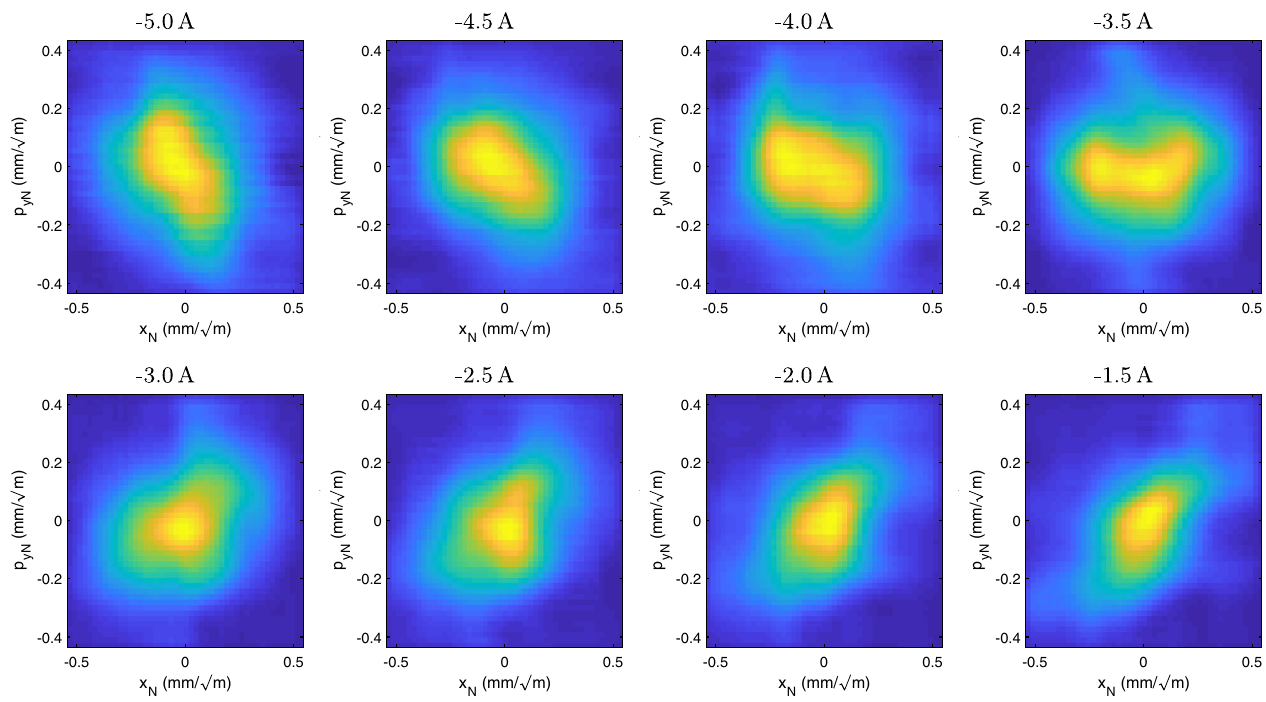
– p FIG. 11. Projection of the beam distribution in normalized phase space onto the x y N plane, reconstructed from four-dimensional N phase space tomography, showing variation of coupling with bucking coil current (given above each figure). The correlation (tilt) between horizontal coordinate x and the vertical momentum p y indicates the strength of the N N